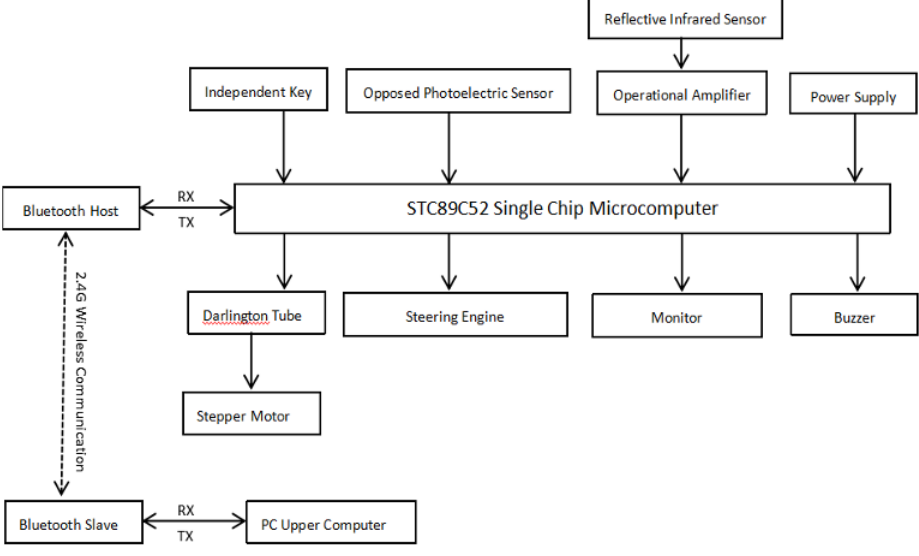
Fig. 1. Overall system block